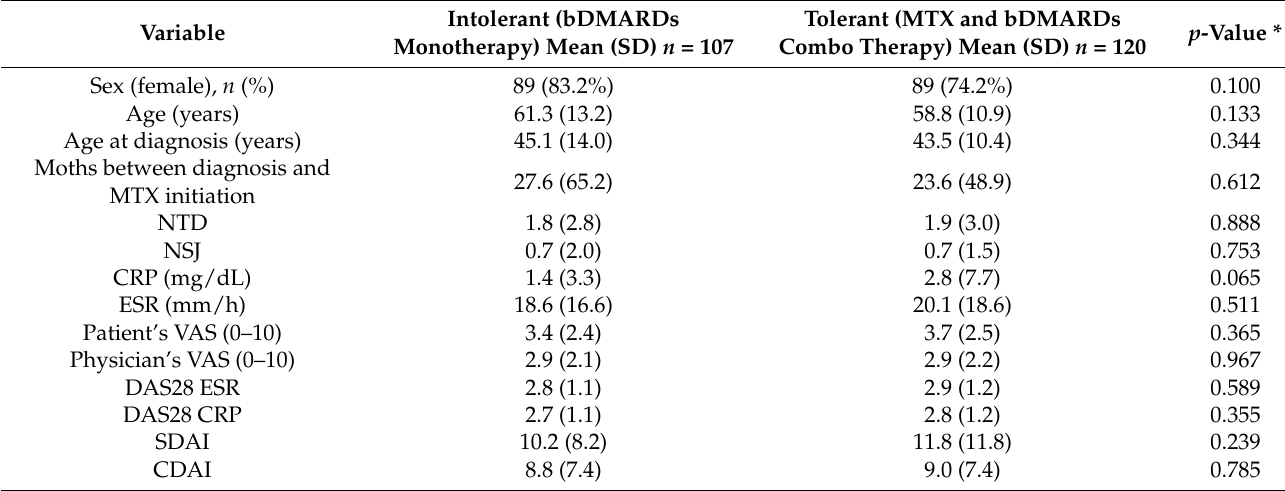
Table 1. Sociodemographic characteristics and disease activity at the study visit between tolerant and intolerant patients.